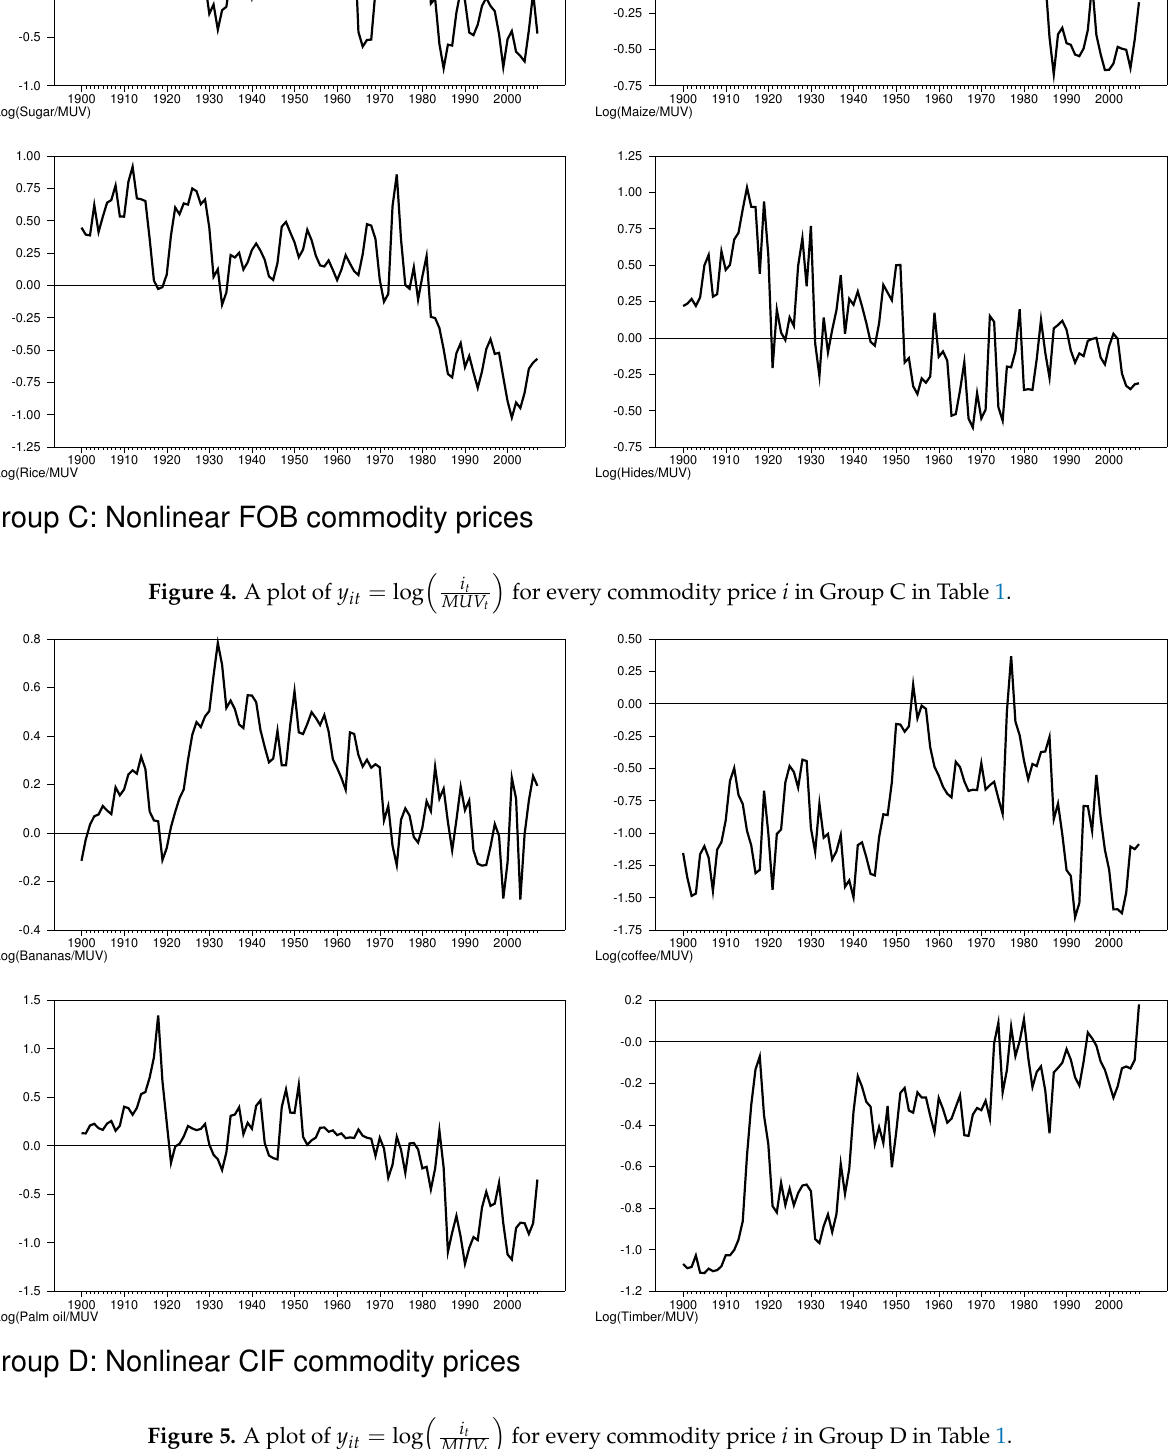
Figure 5. A plot of y it = log